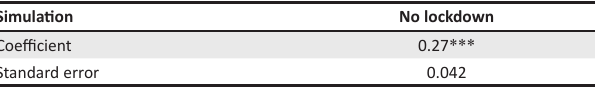
TABLE 4: Probability to be happy if we assume no lockdown (simulation with Spanish COVID-19 cases).